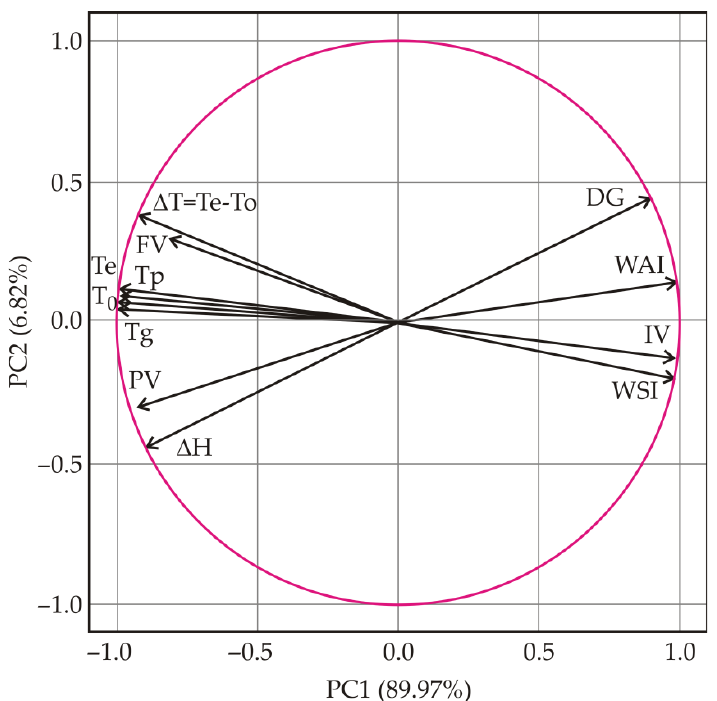
Figure 4. Principal component loading plot for unprocessed and heat-treated corn (onset temperature (T o ), peak temperature (T p ), end temperature (T e ), and enthalpy change ( ∆H ) of starch gelatinization; ∆T -gelatinization temperature range; DG-degree of gelatinization; IV-initial viscosity, PV-peak viscosity, FV-final viscosity, T g -gelatinization temperature; WAI-water absorption index; WSI-water solubility index).